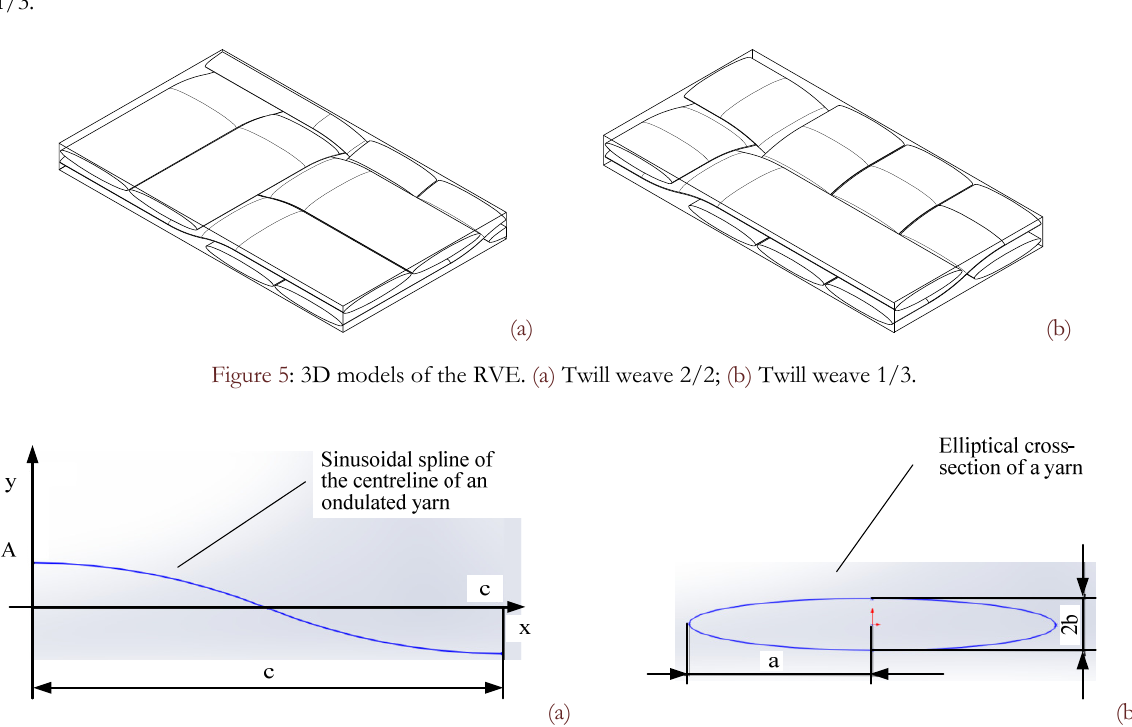
Figure 6: Simplifying assumptions for analytical description of the geometry: (a) Sinusoidal spline about centreline of an undulated yarn; (b) Elliptical cross-section of a